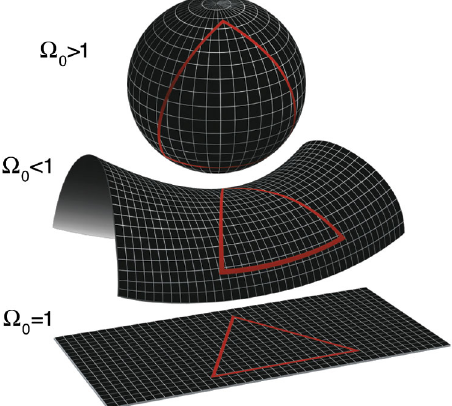
FIG. 13. One variation on the range of representations showing the Geometry of the Universe. Image credit: NASA/WMAP Science Team.